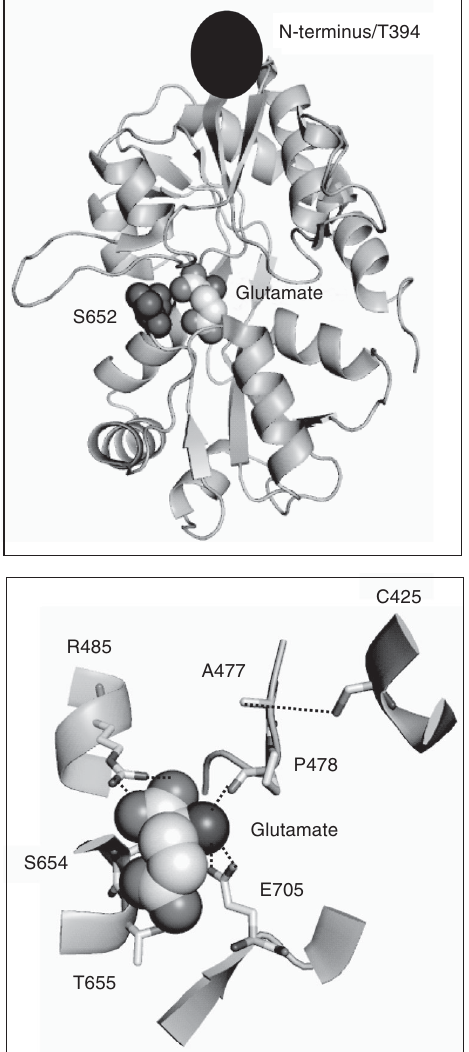
Figure 2. The environment of the ligand glutamate in GluR2-S1S2 (19). The side chain residues in- teracting with the ligand are